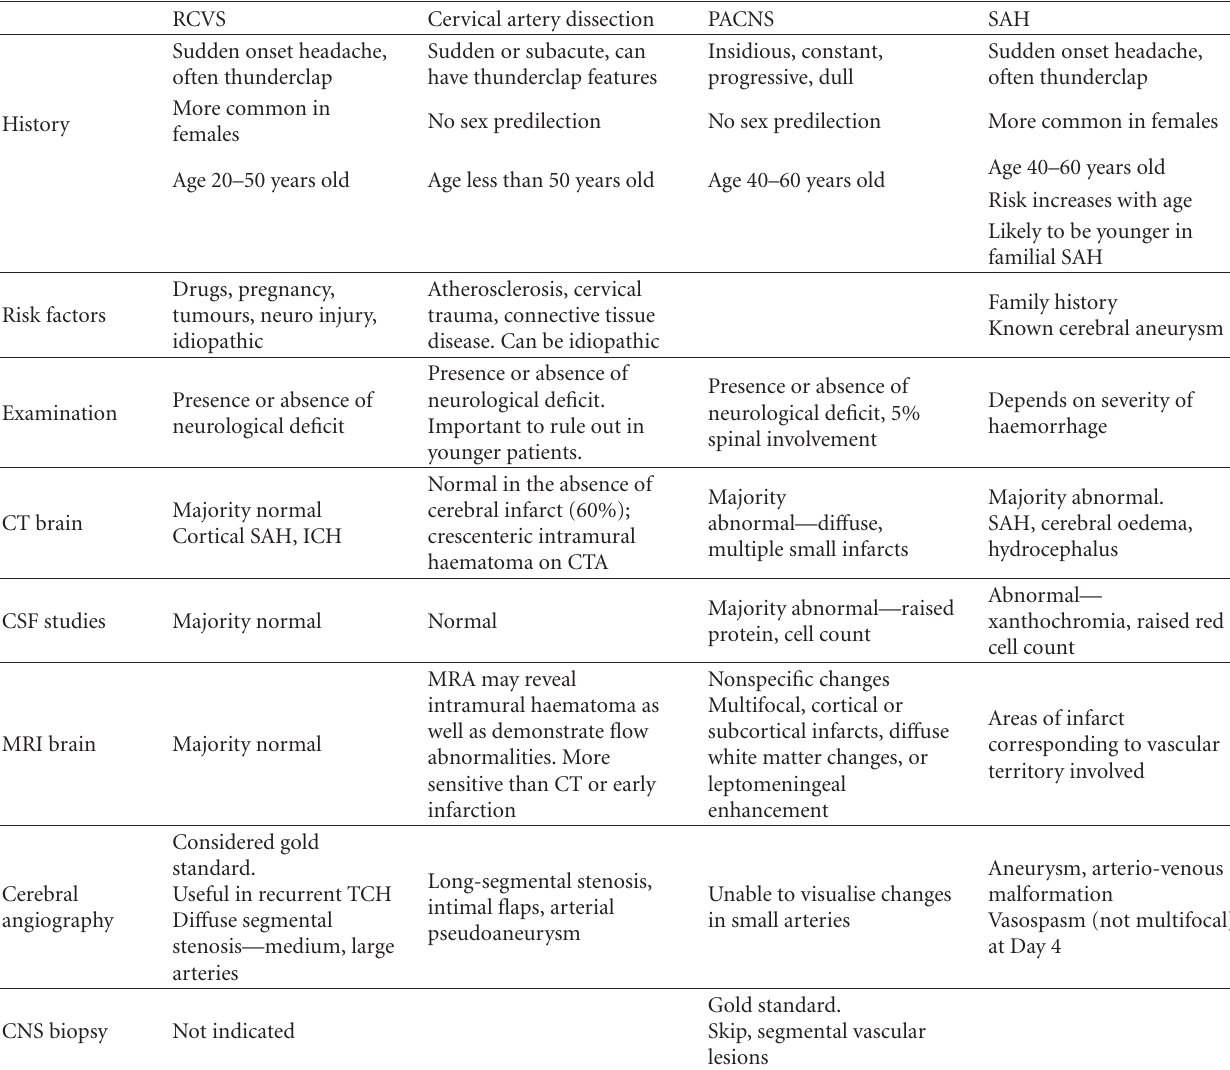
Table 3: Distinguishing features of RCVS, cervical artery dissection, PACNS and SAH